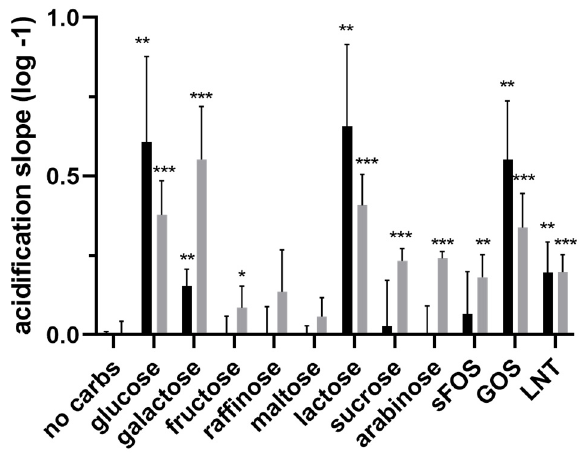
Figure 6. Initial acidification rates of glucose (black bars) or galactose (grey bars) mid-exponentially grown, translationally blocked B. longum NCC 2705 cells that were provided different carbohydrates. Values were extracted from the average logarithmic slopes obtained within the first 200 min of incubation after subtracting background acidification (no carbs) levels. Average acidification rates and standard deviation were calculated from biological triplicate measured in duplicate. Statistical analyses were performed using an unpaired multiple t -test comparing all carbohydrate conditions to the “no carbs” control (* q < 0.01, ** q < 0.001, *** q < 0.0001).